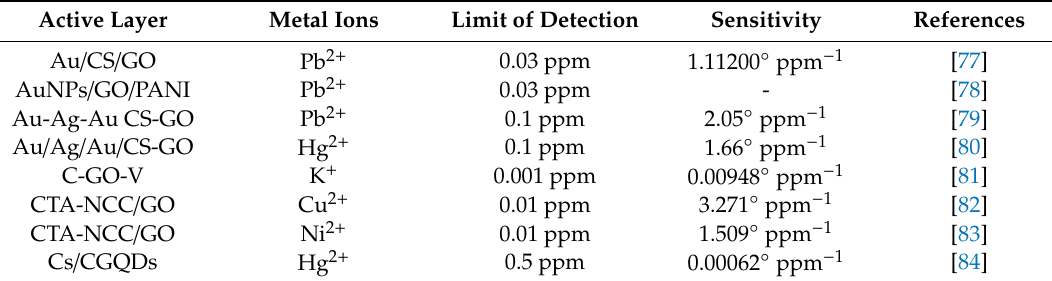
Table 2. Graphene-SPR-based materials in metal ions